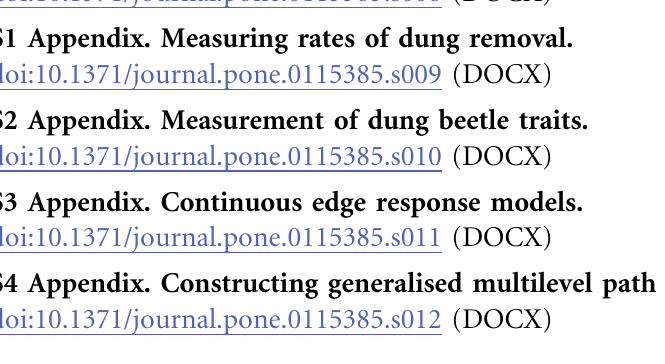
S4 Figure. Contour plot demonstrating the combined effects of total beetle biomass and community-weighted mean body mass on proportion of dung removed. S1 Table. Trait mean values for dung beetle species. S2 Table. List of dung beetle species and their occurrences. S3 Table. Akaike Information Criterion (AIC) scores obtained from the edge function fitting procedure. S4 Table. Complete basis set of independence claims for the selected best-fit path